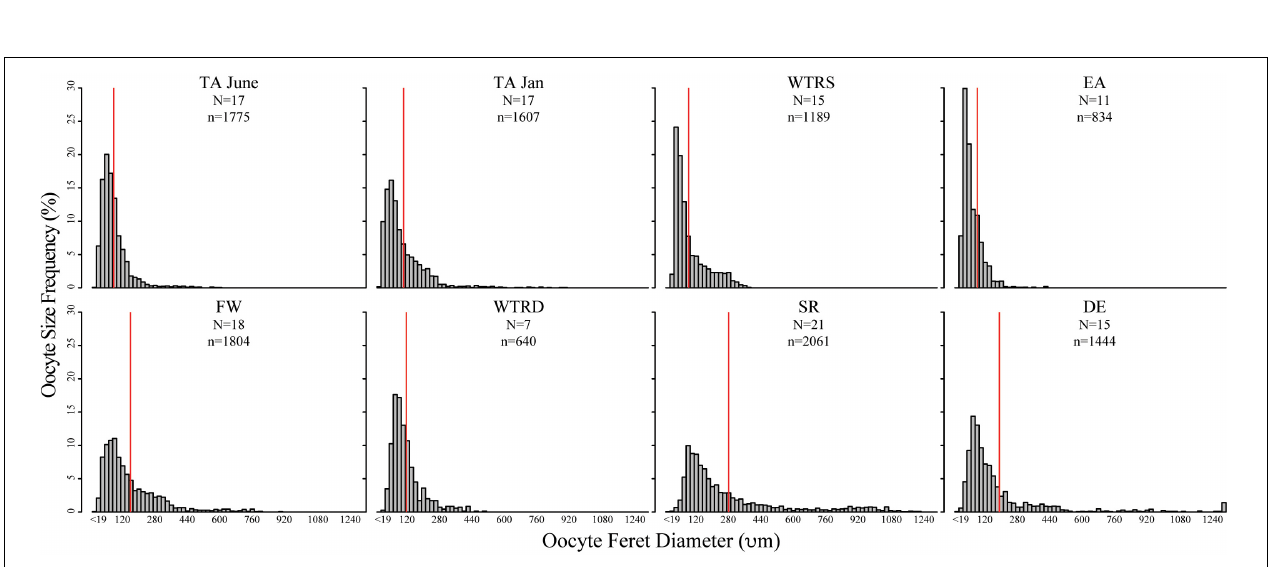
FIGURE 3 | Oocyte size-frequency histograms for sampling sites in this study. Red lines indicate the mean oocyte size. Histograms are arranged from are arranged from shallowest site (top left) to deepest site (bottom right) . Scales are identical for each plot. N , number of colonies used; n , number of total oocytes counted.